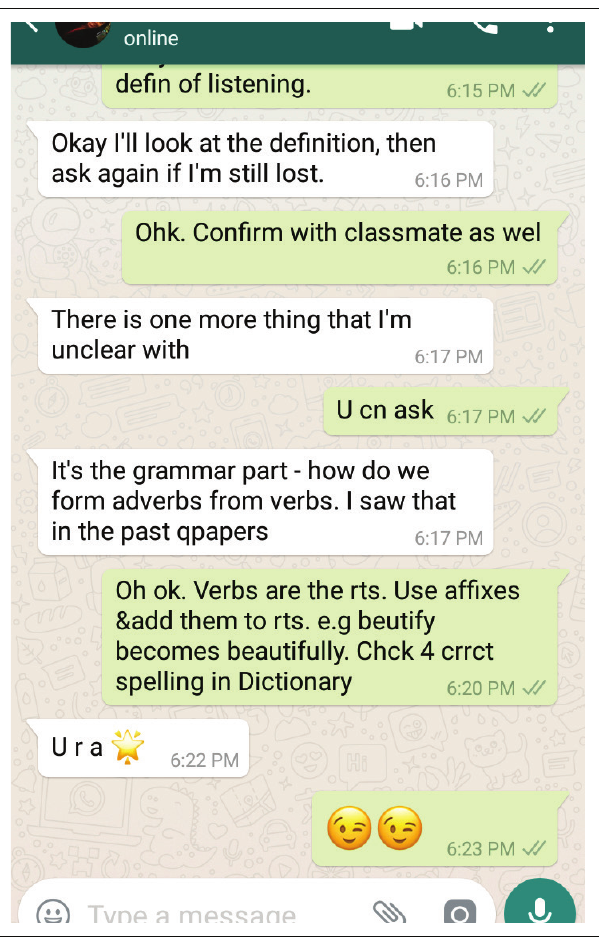
Figure 1 indicates that the conversations are taking place online and learners use their digital literacy skills such as composing messages, typing (electronic writing), punctuating and responding to requests during chat sessions. Learners ask questions during the conversations, and voluntary participation results in sharing of information. An analysis of the extract also shows the use of short forms, abbreviated language and emoticons. Participants